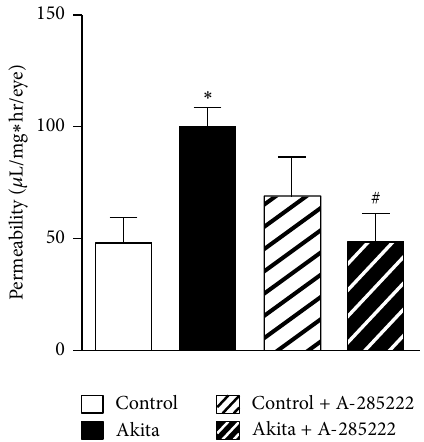
Figure 7: In vivo inhibition of NFAT reduces diabetes-induced vascularpermeability.Vascularpermeability( 𝜇 L / mg ∗ hr / eye)inthe retinas of 8-week-old Akita mice and WT mice that had been treated for 2 weeks with daily i.p. injections of A-285222 (0.29 mg/kg) or saline (control). 𝑁 = 8 , 10, 7, and 7 for WT, Akita, WT + A- 285222, and Akita + A-285222, respectively. Two-way ANOVA with Bonferroni post hoc test revealed ∗ 𝑃 < 0.05 versus WT and ## 𝑃 < 0.05 versus